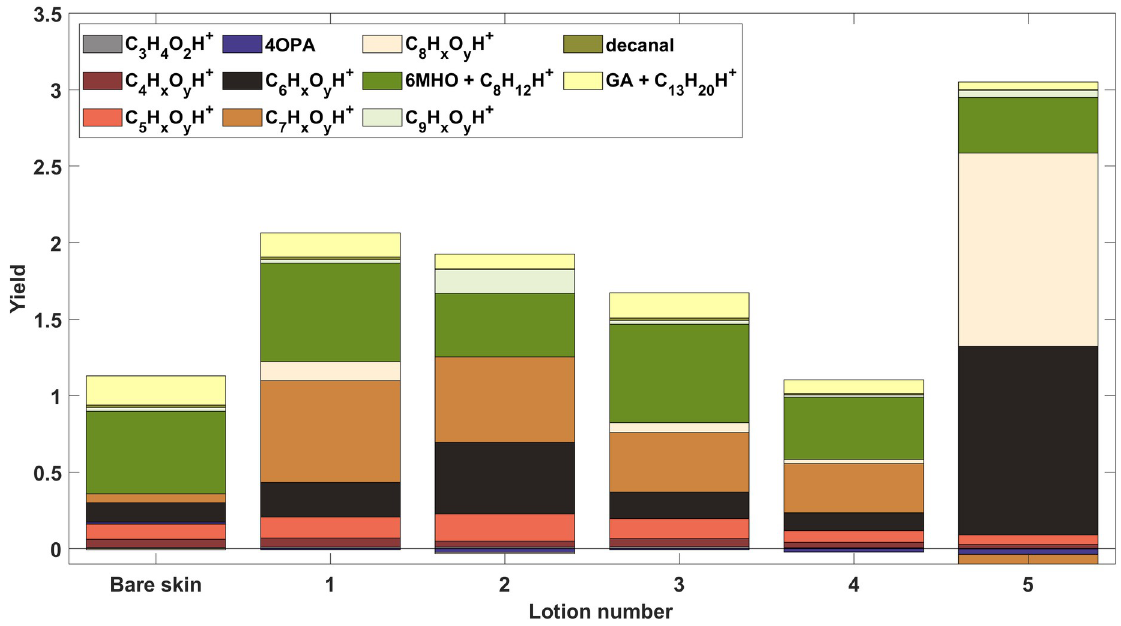
Fig 4. Product yields. Yields of individual species as well as ions grouped by number of